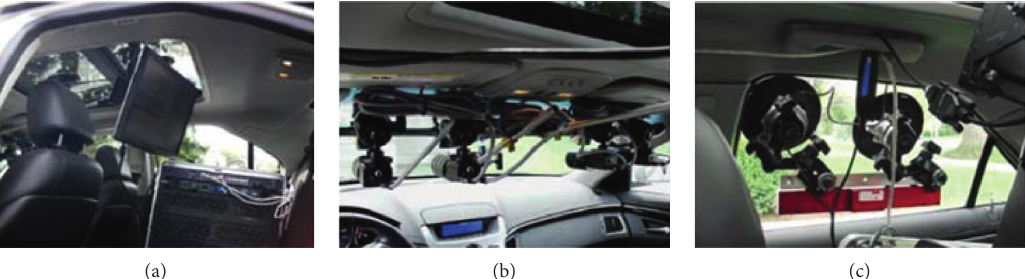
Figure 1: The RoadLab in-vehicle laboratory: (a) on-board computer and LCD screen; (b) dual stereo front cameras; (c) side stereo cameras.